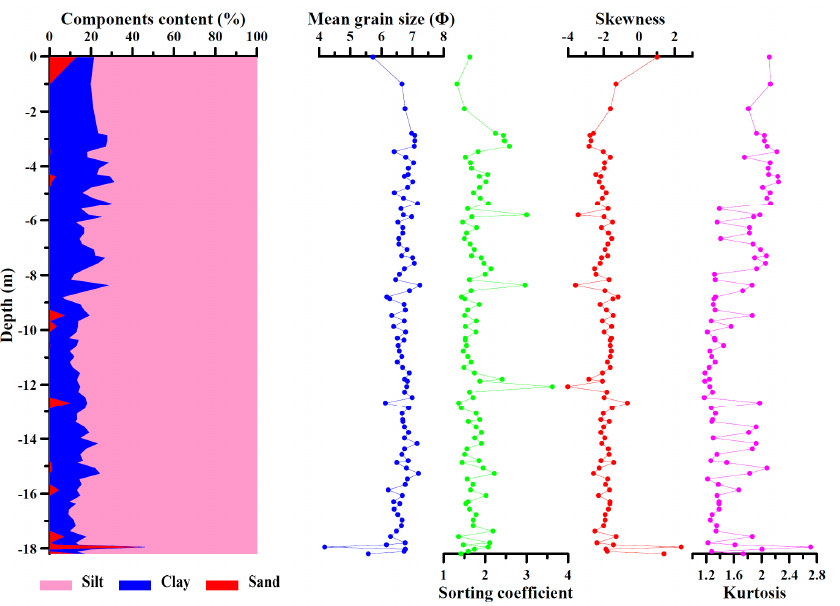
Figure 6. Vertical distribution characteristics of sediment grain size from Core WH-05.